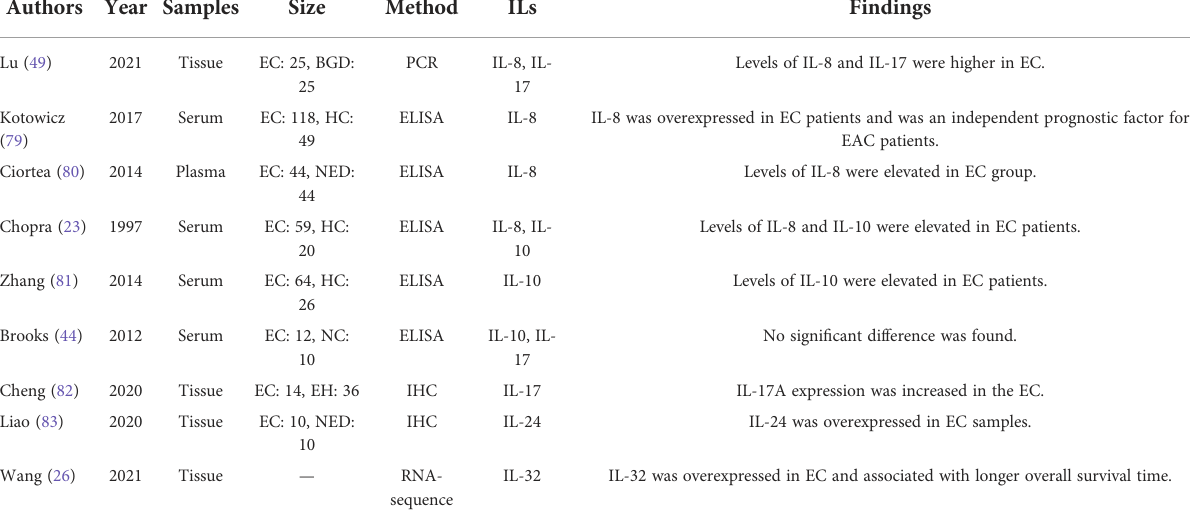
TABLE 3 The expression of the other interleukins in EC. Authors Year Samples